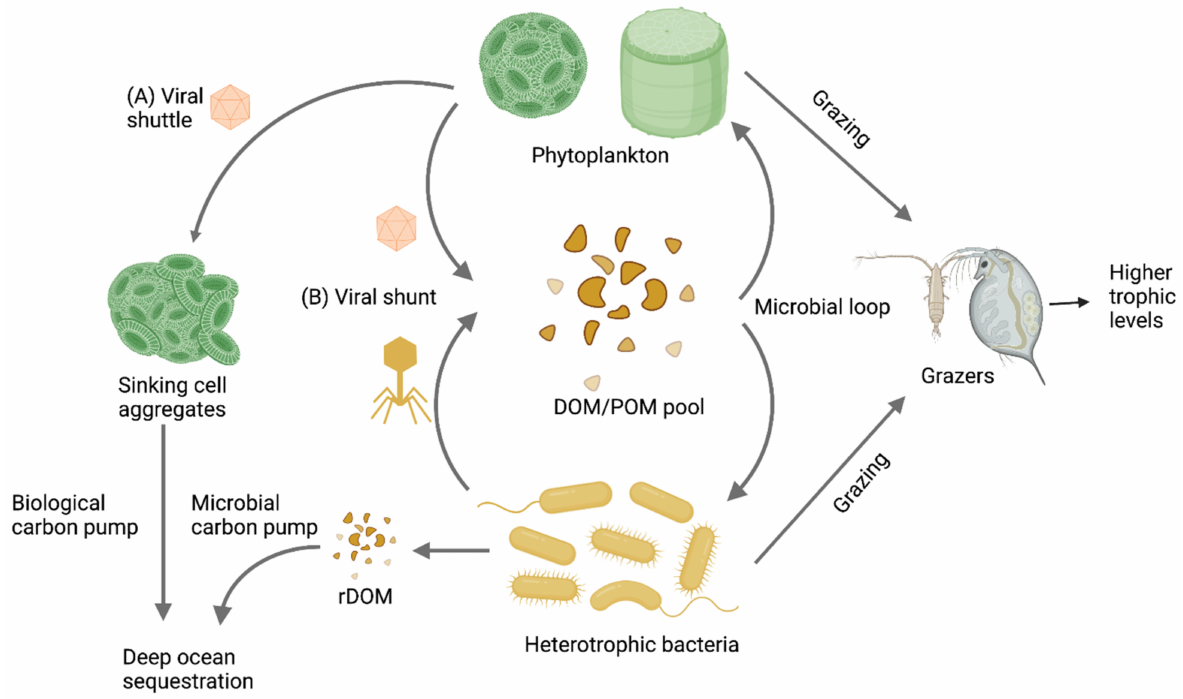
Figure 2. Marine viruses simultaneously control two processes in the carbon cycle: ( A ) the viral shuttle and ( B ) the viral shunt. In the viral shuttle, viral lysis of phytoplankton cells produces sticky aggregates with negative buoyancy that enhance the biological carbon pump by sequestrating carbon in the deep ocean. In the viral shunt, viral lysis of cells has the opposite effect—it diverts the organic matter into a dissolved organic matter (DOM) pool that is rapidly and continuously recycled in the surface waters, preventing its sequestration or uptake by higher trophic levels. Adapted from [4]. Created in